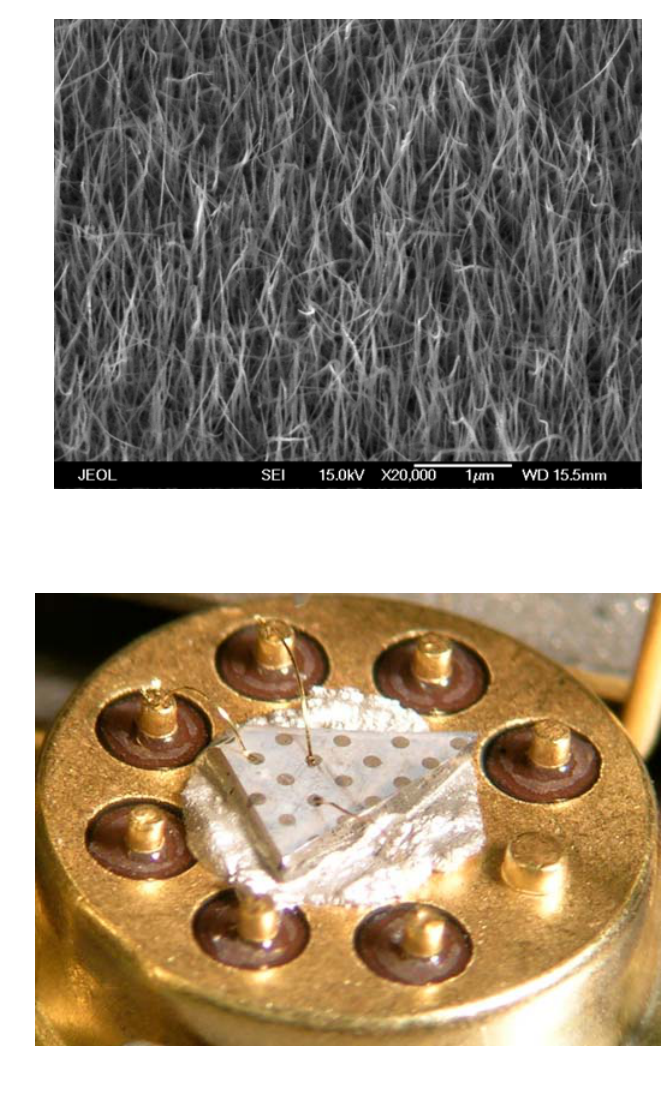
Figure 9. SEM of ZnO multiple nanorods (top) and photograph of the nanorods contacted by Al/Pt/Au electrodes (bottom).The ZnO chip has edge length ~ 5mm in the bottom